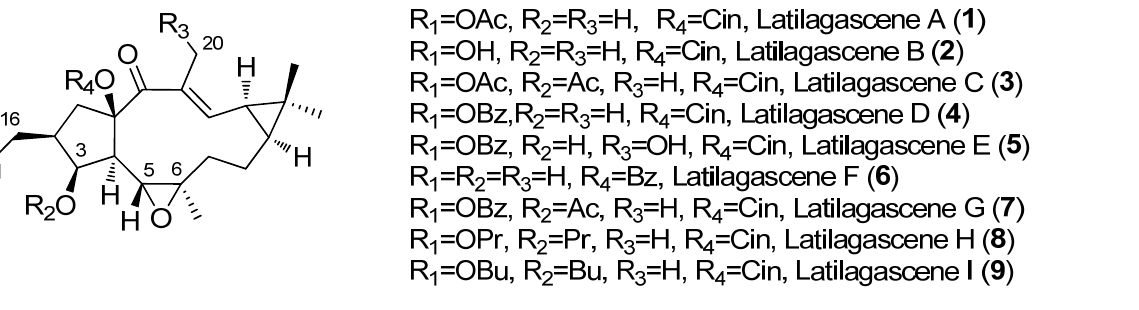
Figure 3. Chemical structures of latilagascene derivatives (compounds 1 – 9 ) with MDR-modulating activity.